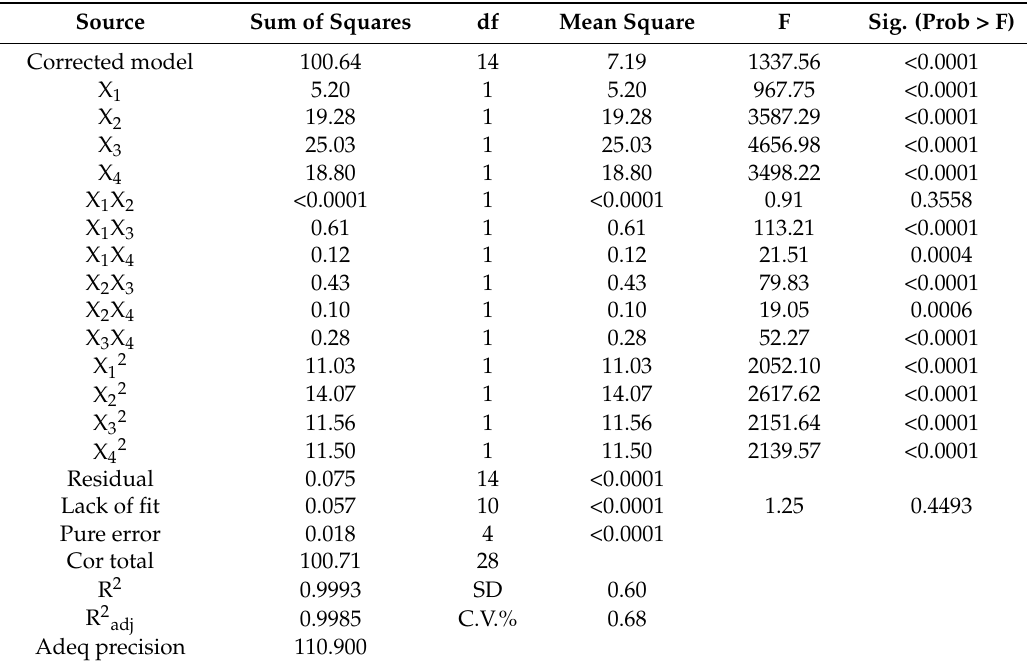
Table 2. ANOVA for dependent variable: the yield of